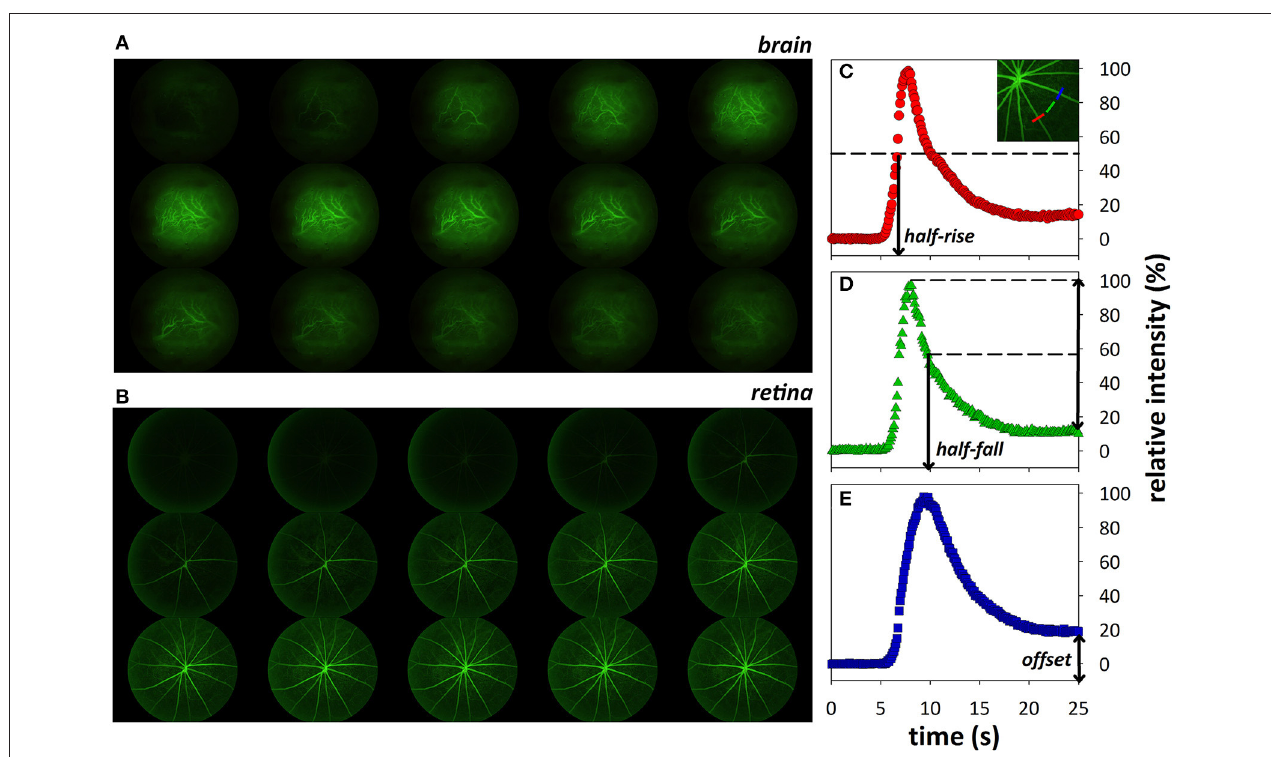
FIGURE 1 | Montage (every 20th frame of video recording) showing fluorescein transit through cortical (A) and retinal (B) vasculature 5.2–15.8s after onset of fluorescein infusion. Representative intensity profiles showing how fluorescence indices, half-rise (C) , half-fall (D) , and offset (E) , were